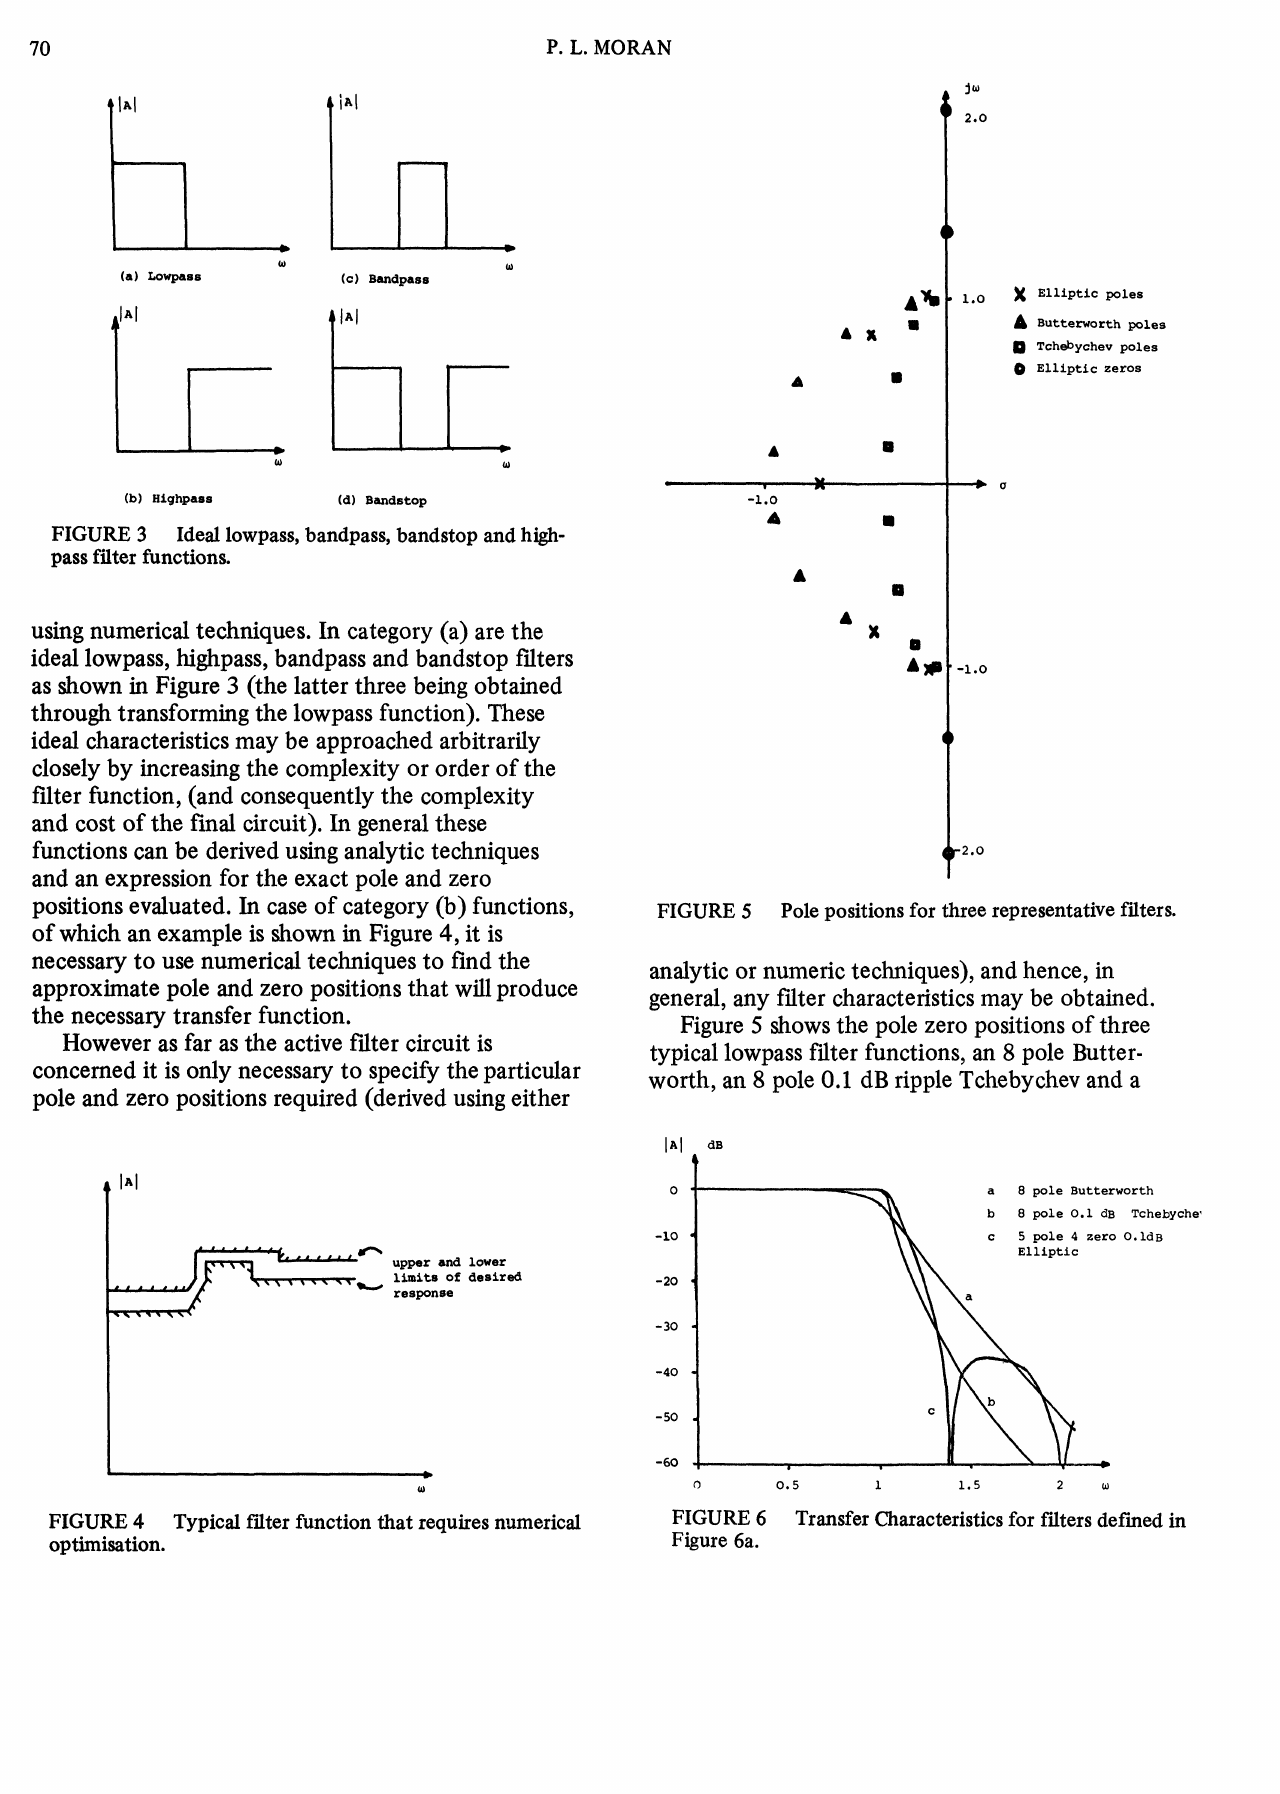
Transfer Characteristics for filters defined Figure 6a.